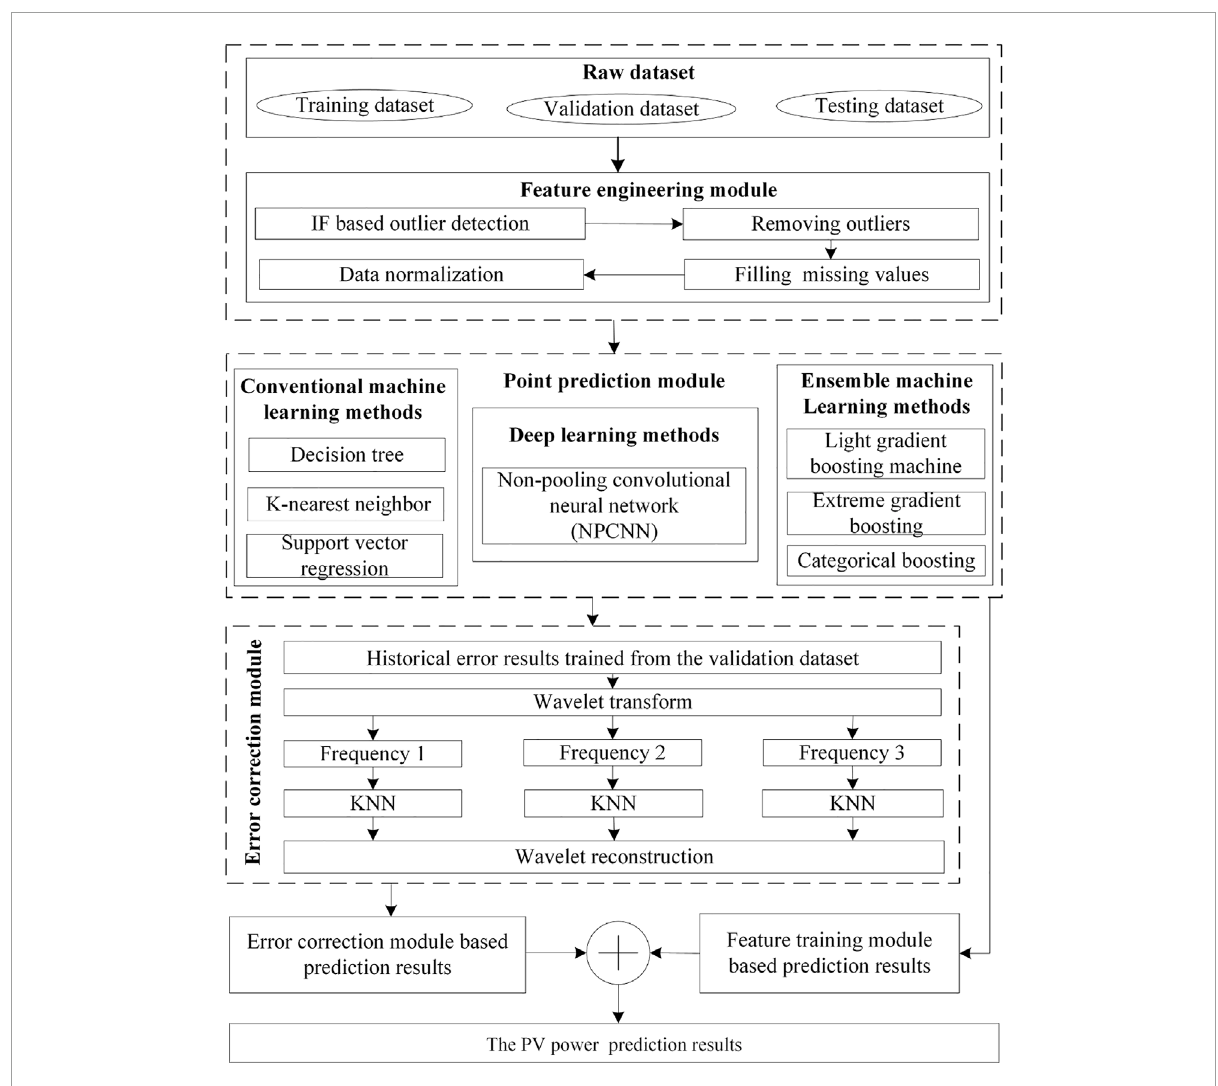
FIGURE 1 The proposed hybrid framework for PV power